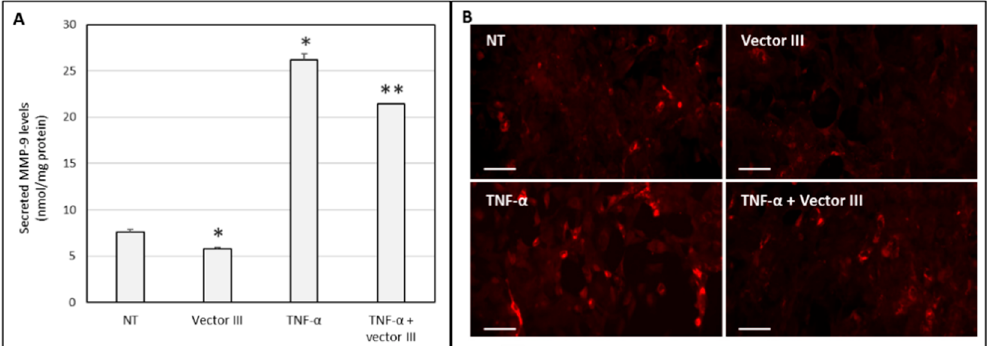
Figure 5. ( A ) The secreted MMP-9 levels in HCE-2 cells untreated and treated with vector III, TNF- α , or both. ( B ) Fluorescence images of immunostained MMP-9 in HCE-2 cells untreated and treated with vector III, TNF- α , or both. NT: non-treated cells. * p < 0.05 respect to non-treated cells (NT), ** p < 0.05 respect to TNF- α . Scale bar: 60 µm.